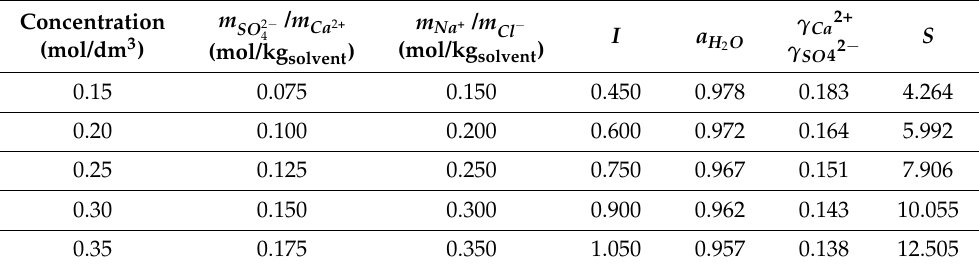
Table 6. Supersaturation, molality, ionic strength, and activity of water for various concentration and constant temperature of 25 ◦ C.